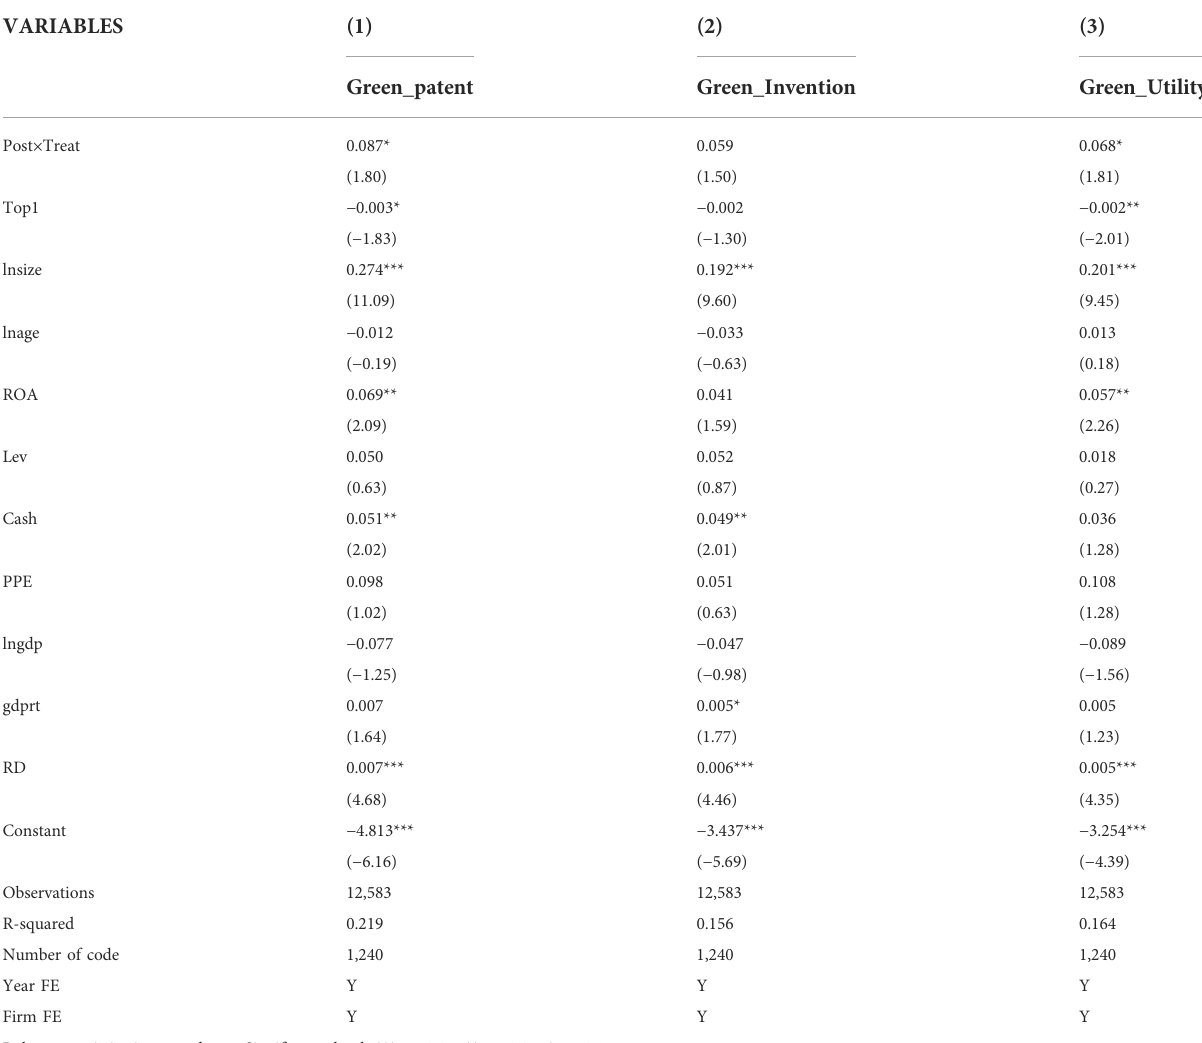
TABLE 3 The impact of low-carbon city pilot policy on green innovation.